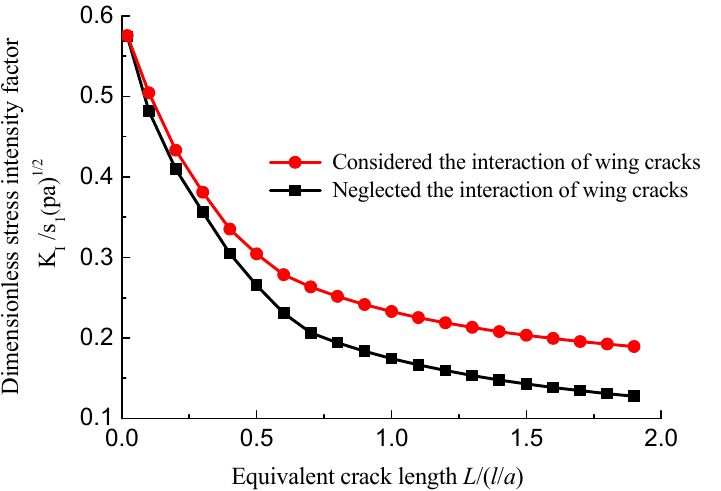
Figure 19. Comparison of stress intensity factor at the wing crack tip considering the interaction of multiple wing cracks.